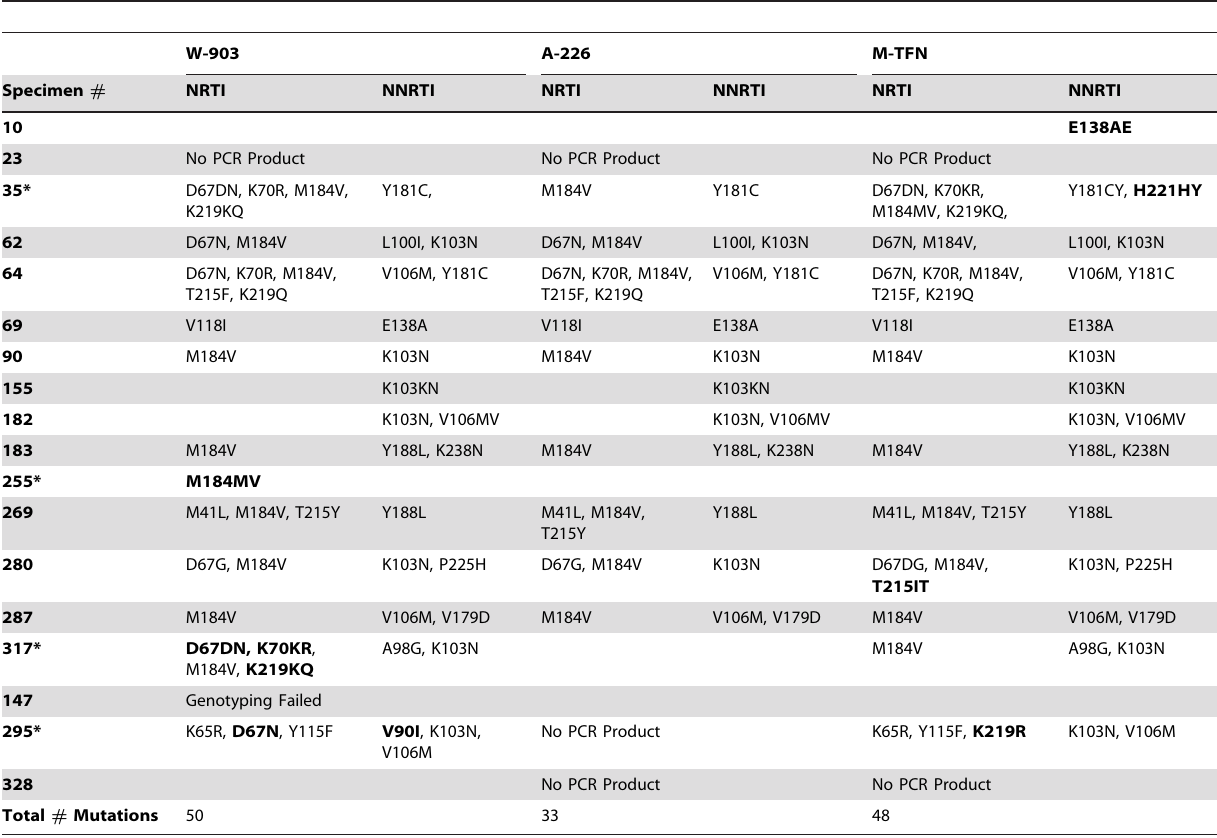
Table 2. HIV drug resistance mutation Profiles of DBS specimens collected on W-903, A-226, and M-TFN filter